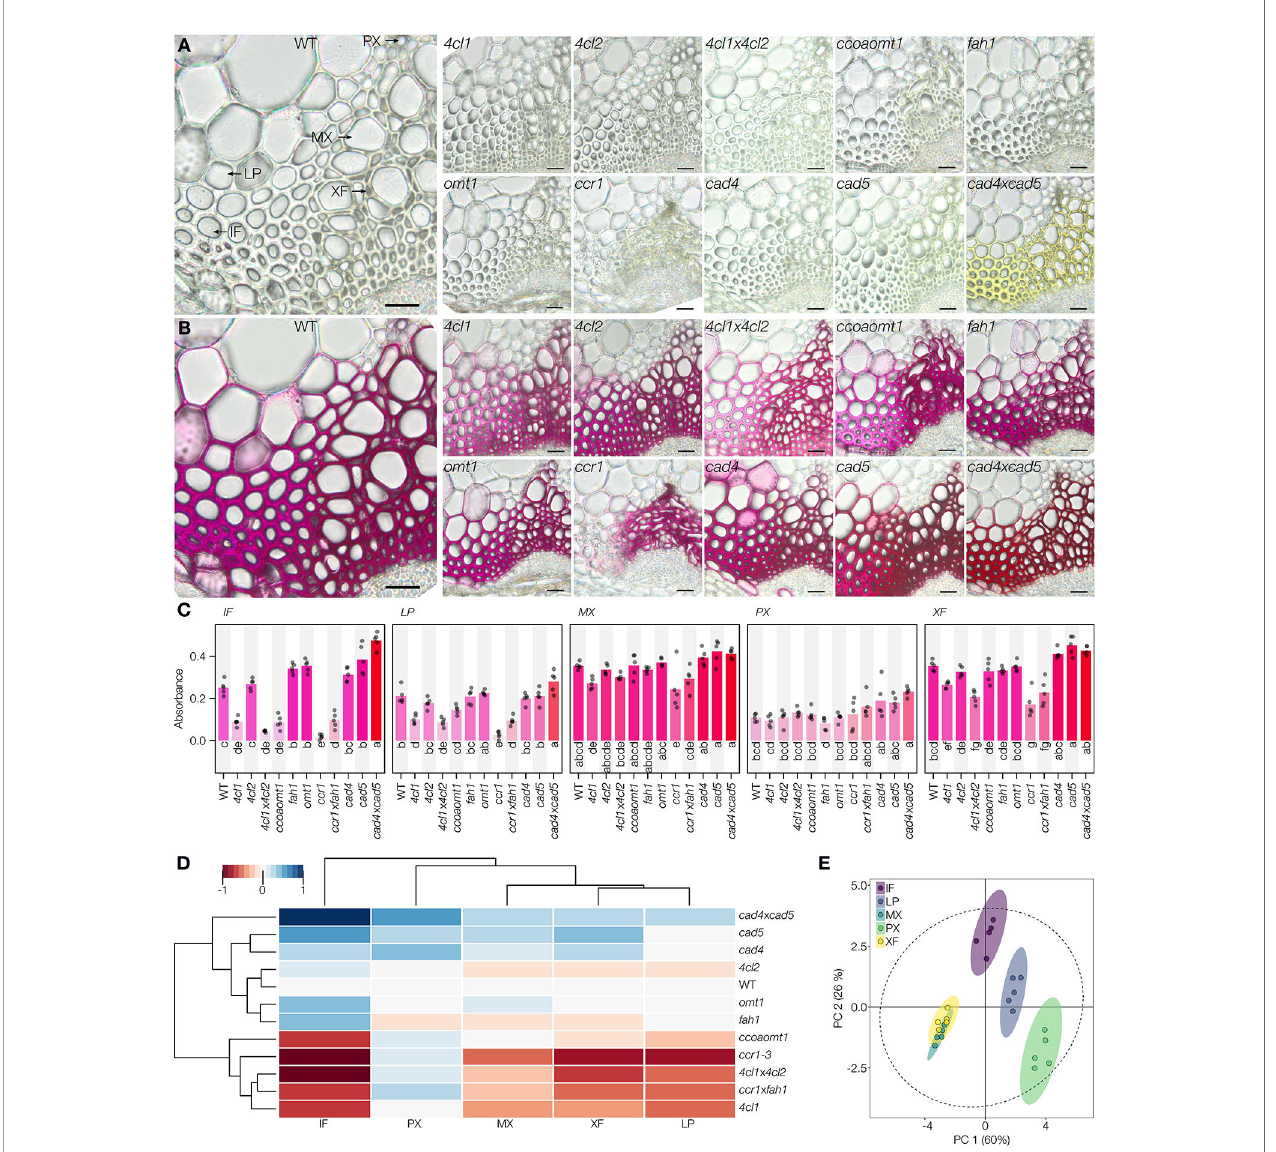
FIGURE 5 | Reaction of the Wiesner test on genetically modi fi ed lignin in Arabidopsis . (A, B) 50 µm sections of the different genotypes before (A) and after (B) staining. Ligni fi ed cell types include interfascicular fi bers (IF), ligni fi ed parenchyma (LP), metaxylem vessels (MX), protoxylem vessels (PX), and xylary fi bers (XF). Bars = 25 µm. (C) Changes in absorbance in response to the Wiesner test monitored in the fi ve different cell types for the different genotypes. Circles indicate the average of each individual replicate and bars represent the average per genotype. Quanti fi cation was done on 50 measurement points of 12 pixels each per cell type in fi ve independent plants. The color of bars re fl ects the respective average color of the stain. Letters indicate signi fi cant differences according to a Tukey-HSD test (per panel; con fi dence limit a = 0.05). (D) Hierarchical clustering of the Wiesner test absorbance in the fi ve ligni fi ed cell types in 12 genotypes using the range normalized Euclidean distance of their average difference from the WT. (E) Principal component analysis of the fi ve ligni fi ed cell types according to their absorbance in the 12 tested genotypes; 95% data ellipses are